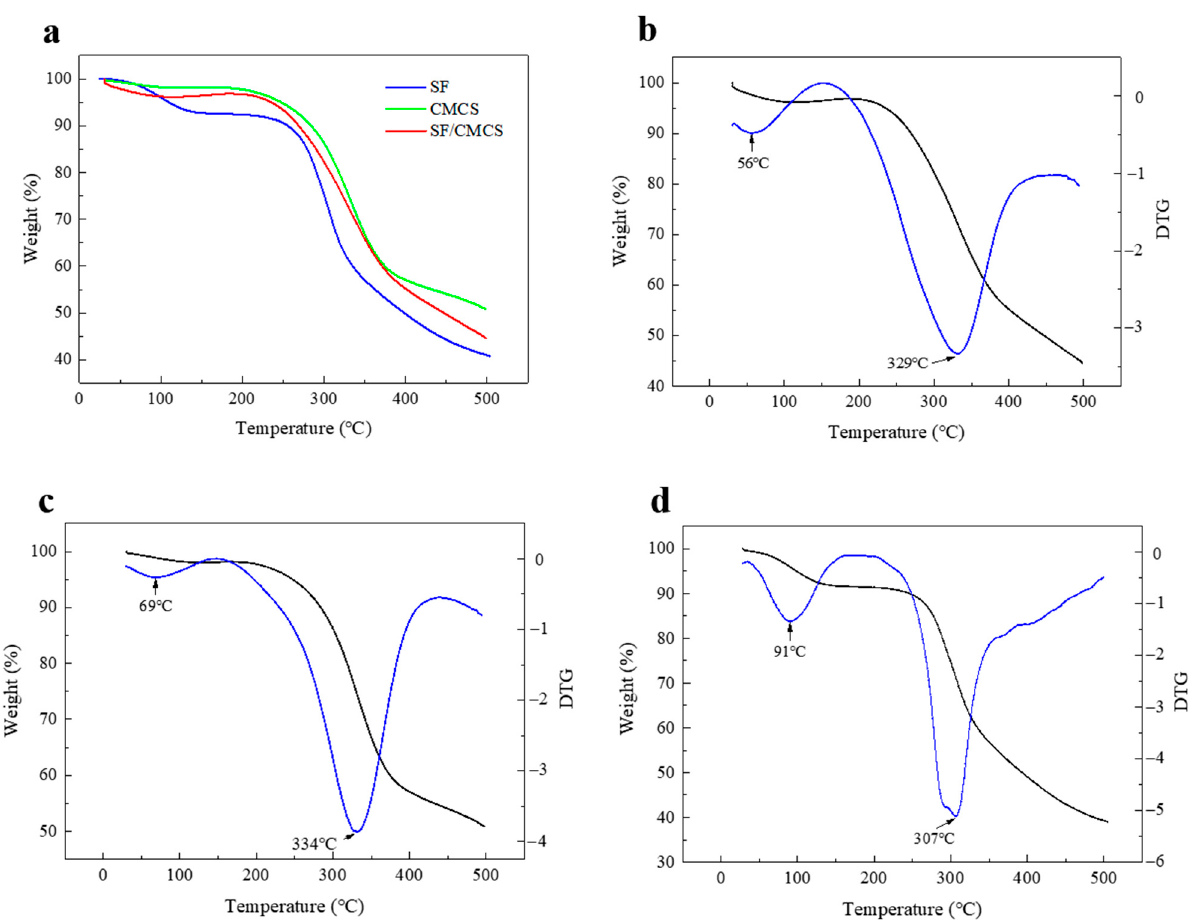
Figure 5. ( a ) TGA curves of the SF sponge, CMCS hydrogel, and SF/CMCS hydrogel. TGA traces (black dashed line) and the corresponding DTG thermographs (blue solid line) of ( b ) SF/CMCS hydrogel, ( c ) CMCS hydrogel, and ( d ) SF sponge.